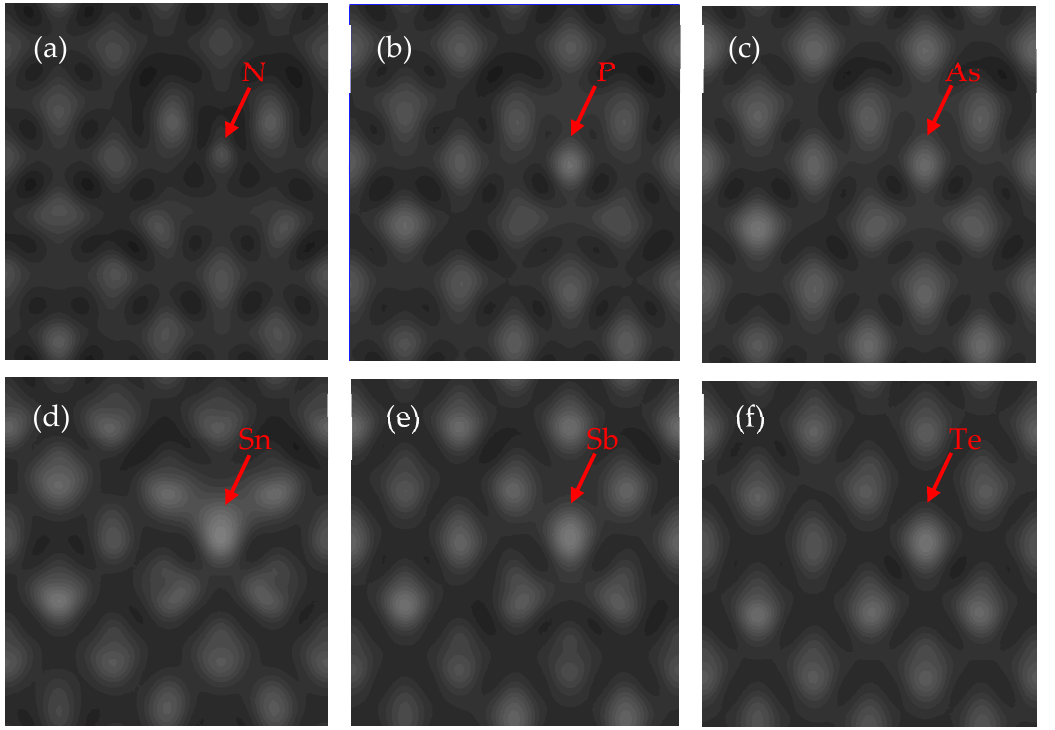
Figure 6. STM profiles of the doped models of GeSe_N ( a ), GeSe_P ( b ), GeSe_As ( c ), GeSe_Sn ( d ), GeSe_Sb ( e ), and GeSe_Te ( f ) under positive bias of 2 V.